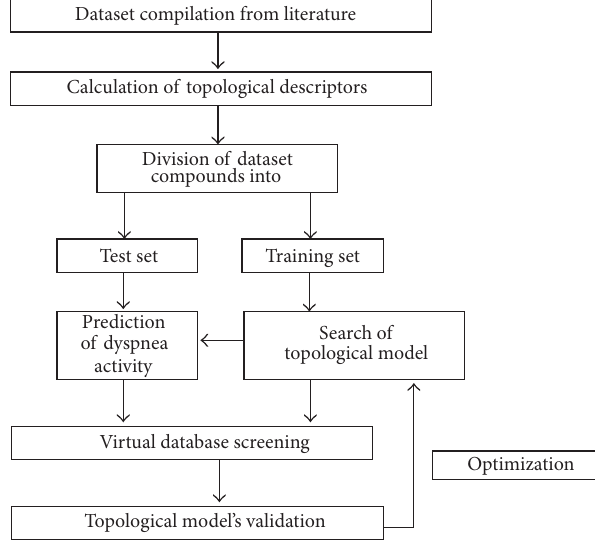
F 1: General scheme of the methodology followed for building up the dyspnea topological-mathematical